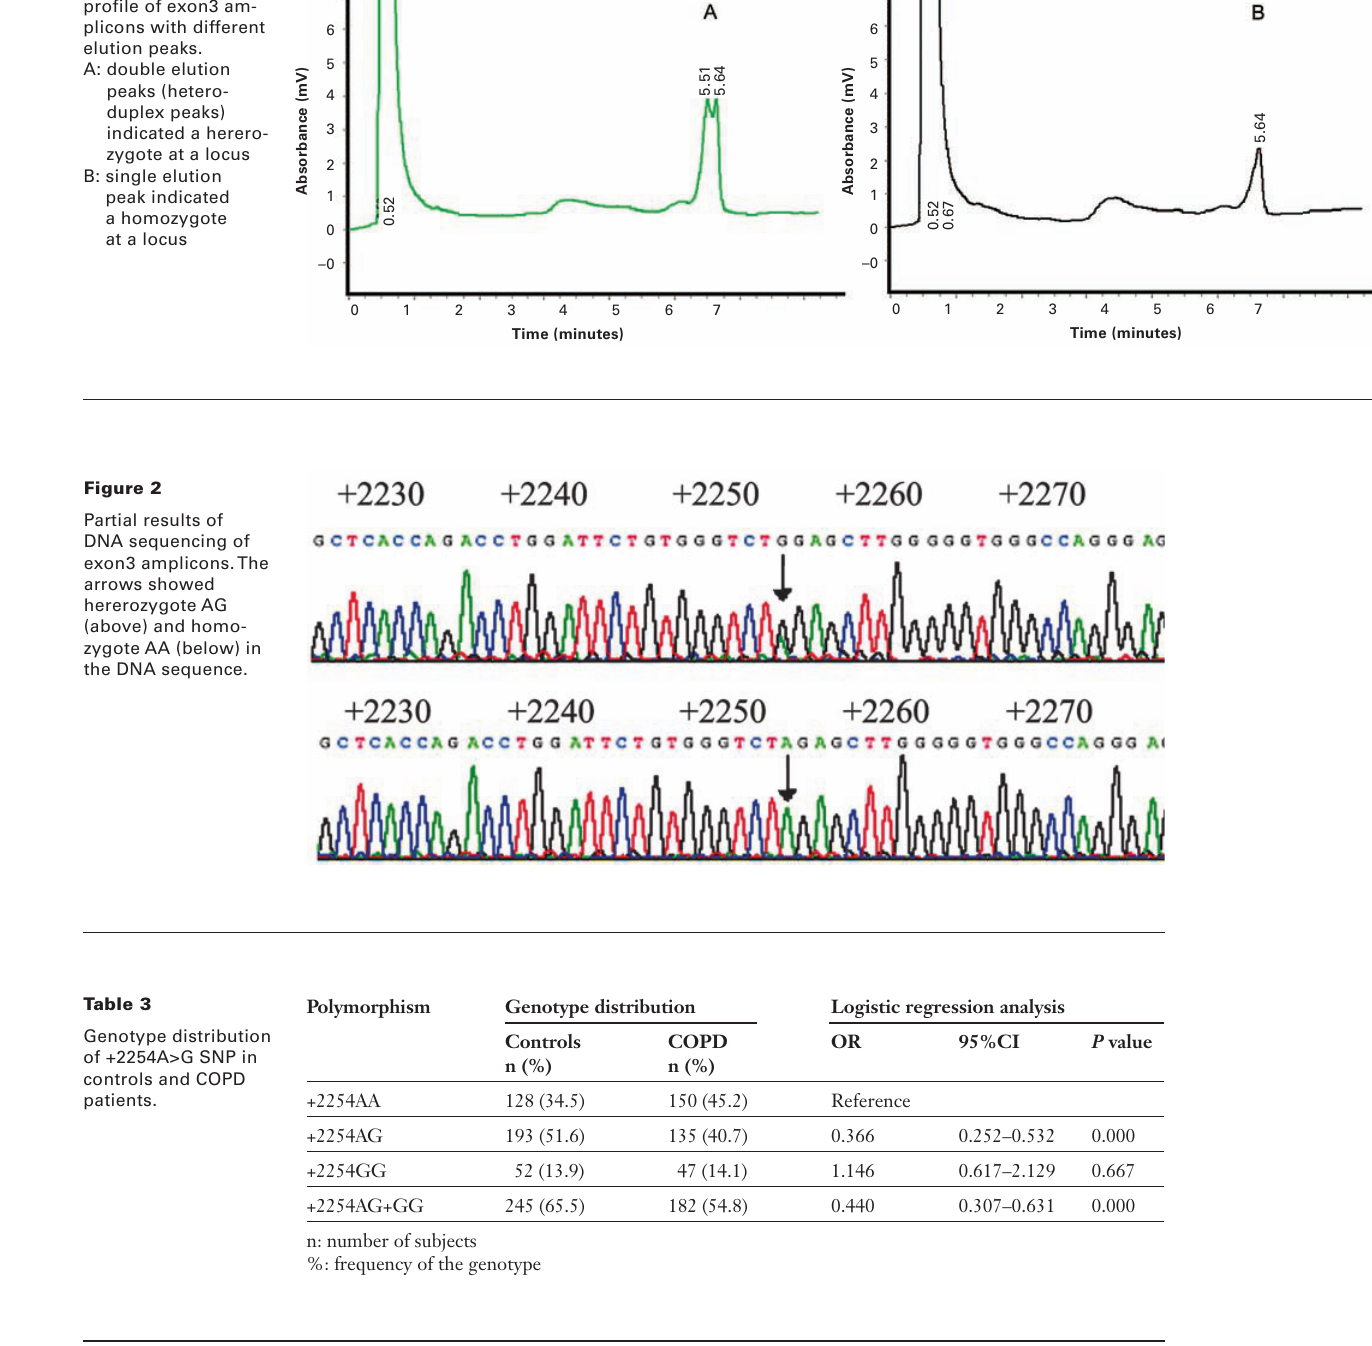
Figure 1 The DHPLC elution profile of exon3 am- plicons with different elution peaks.